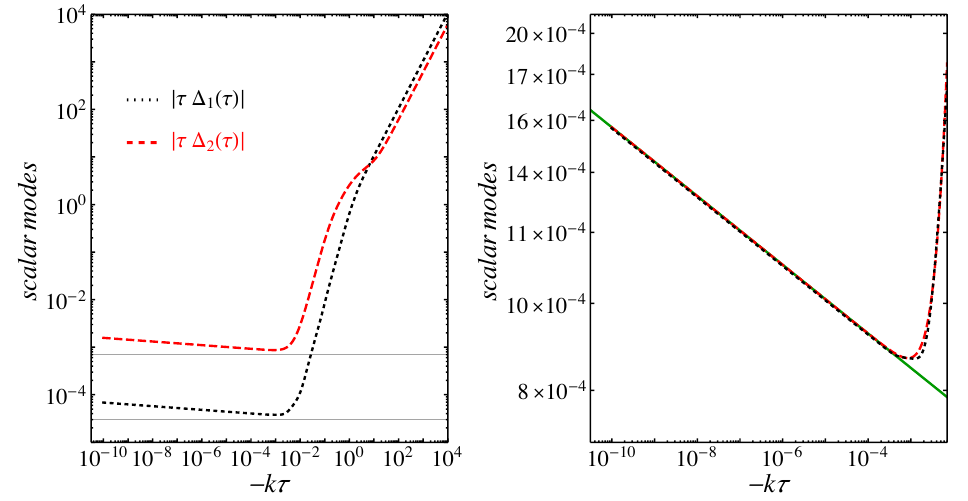
Figure 3 . Left: evolution of scalar (cid:13)uctuations in Gauge-(cid:13)ation for (cid:15) = 0 : 01 and (cid:13) = 5. Right: a zoomed region of the left panel with the modes rescaled according to eq. (3.47) . The solid green line corresponds to the analytically calculated growth rate for these parameters. The black-dotted curve has been vertically shifted using the eigenvector given in eq. (3.47) , in order to align with the red curve at late times and (cid:12)t in a single